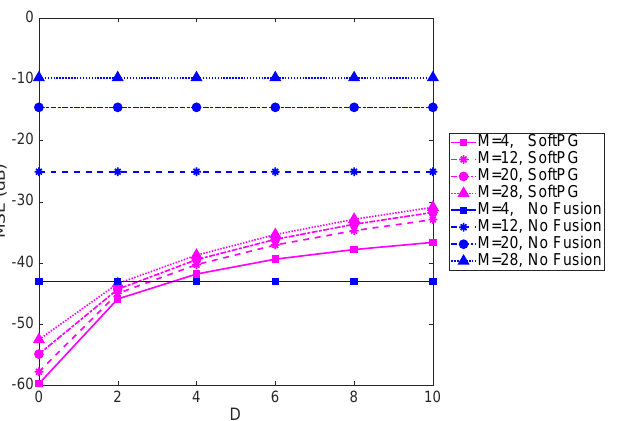
Figure 4. MSE as a function of the normalized delay for different values of M , the size of the state vector. The No Fusion curves are shown as the benchmark. Number of observations per PE is 9.